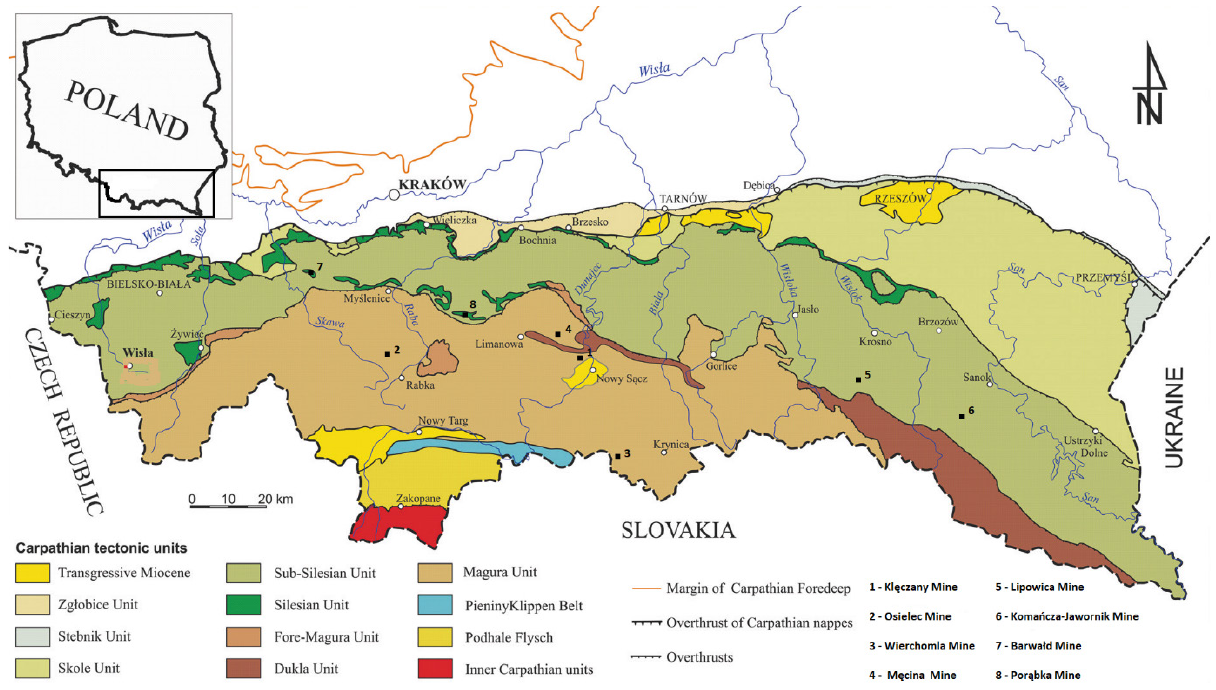
Figure 1: A simplified geological and structural map of the Polish Carpathians [5, 16, 23, 30].